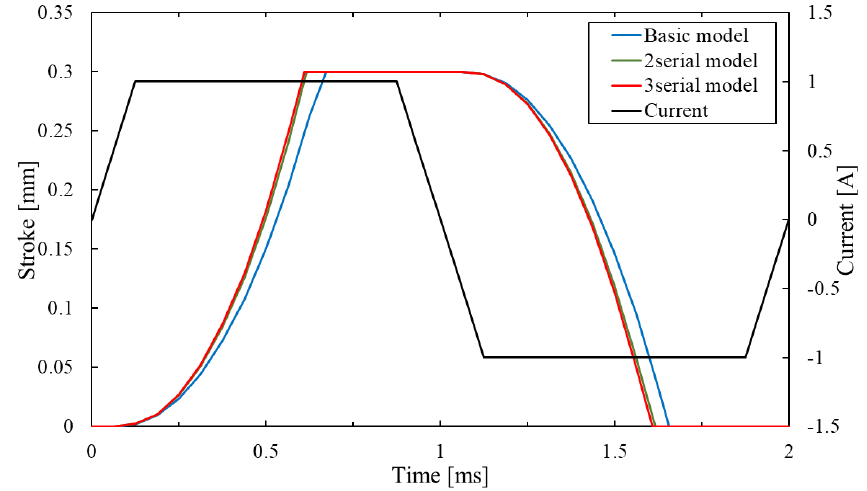
Figure 15. Response waveform of a serial